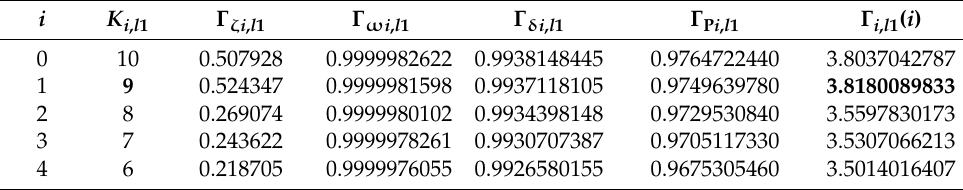
Table 7. Weight functions for PSS parameters T = 0.5 s, K i,ln = 6–10, n = 1 (l ower cluster 1 ), t = 30 ms.